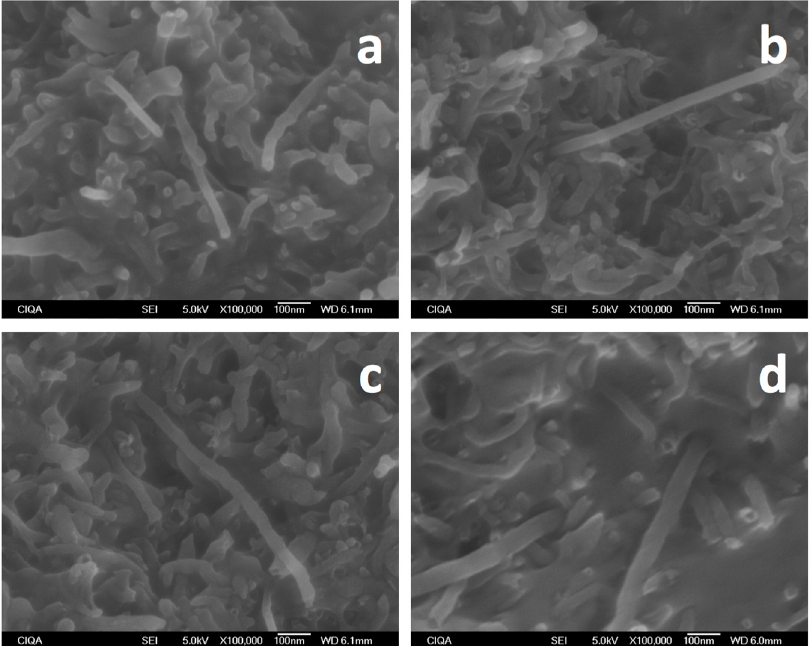
Figure 6. SEM micrographs within agglomerates for iPP MFI=34 /MWCNT fabricated using different ultrasound-assisted extrusion methods ( a ) W-U; ( b ) F-U; ( c ) V-U; and ( d ) PT.